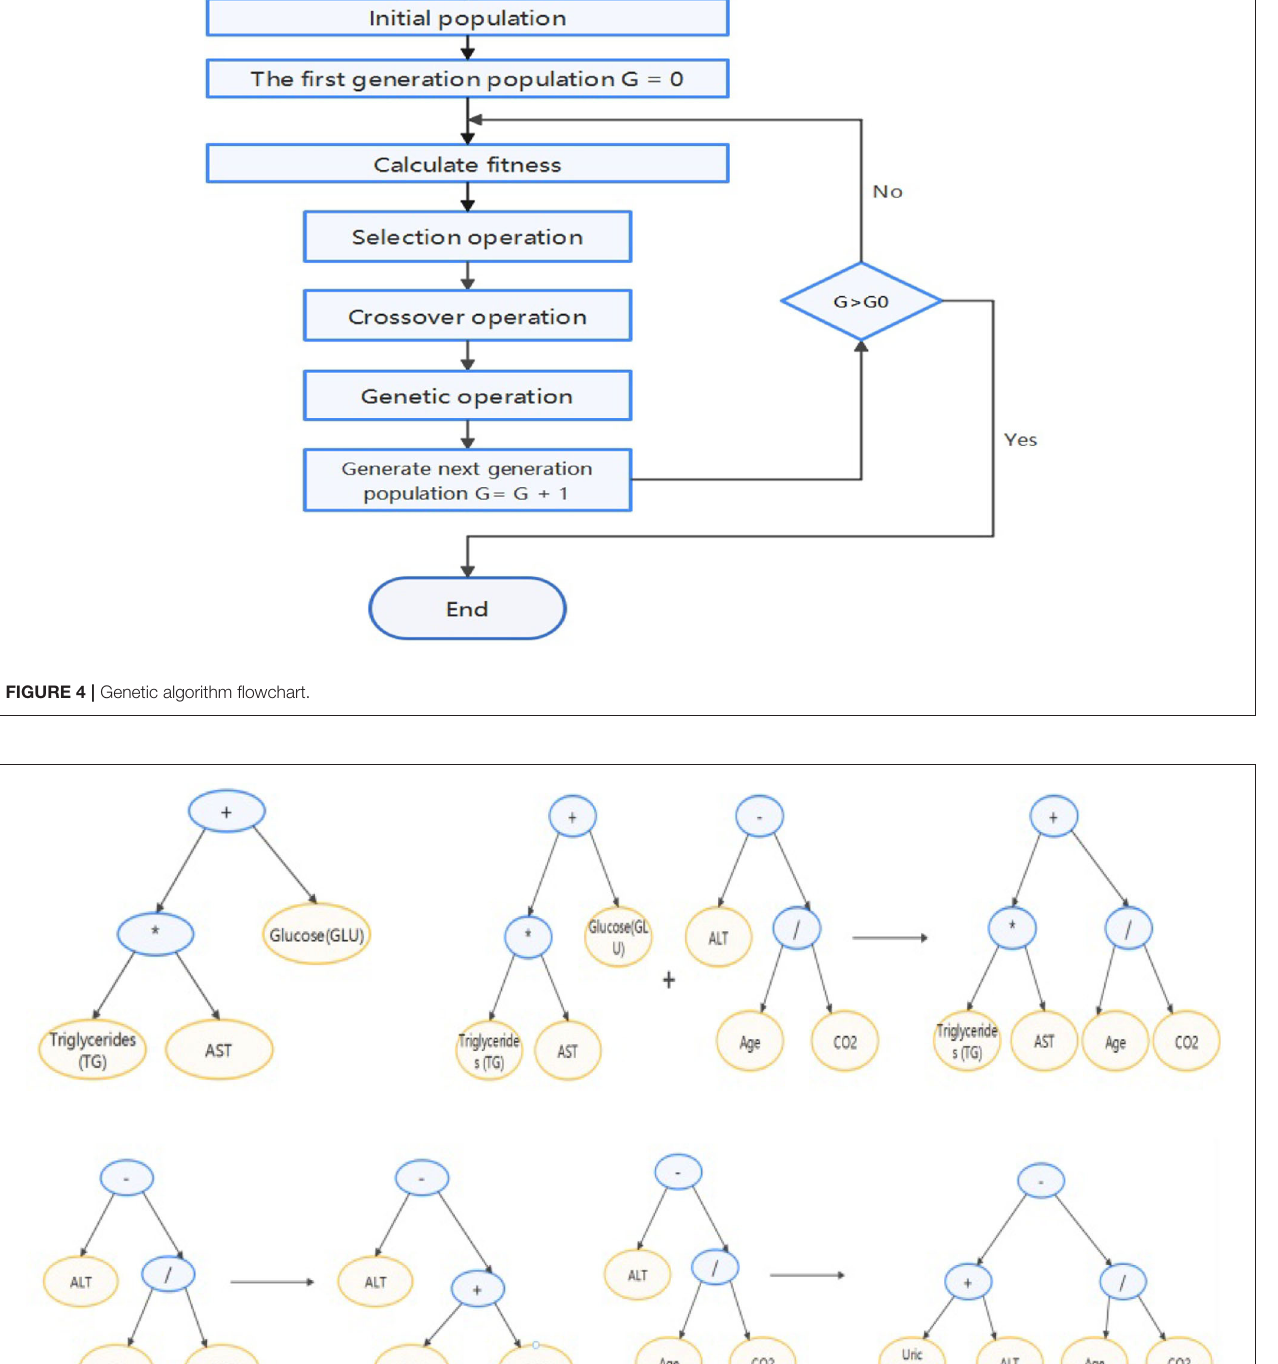
Frontiers in Public Health |